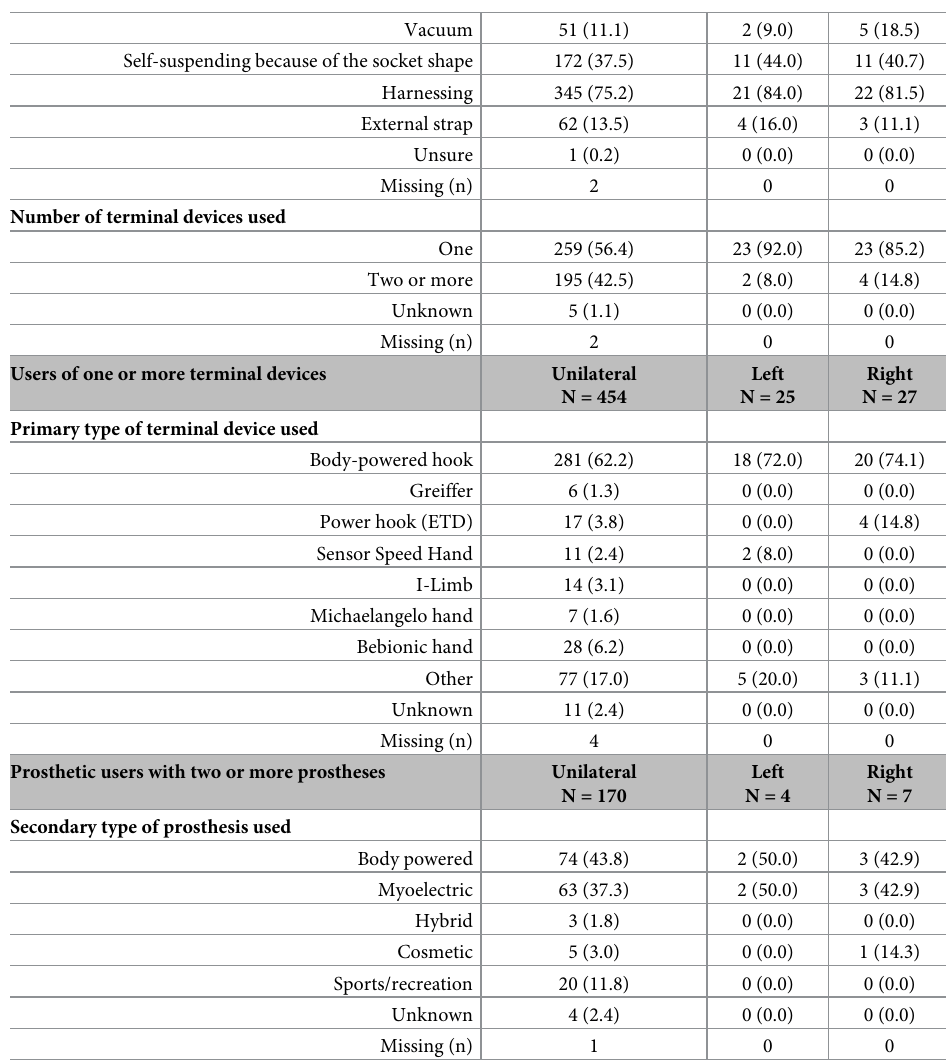
silicone liners with pin (37.5% unilateral, 44.0% left and 40.7% right bilateral), and suction (34.0% unilateral, 20% left and 29.6% right bilateral).